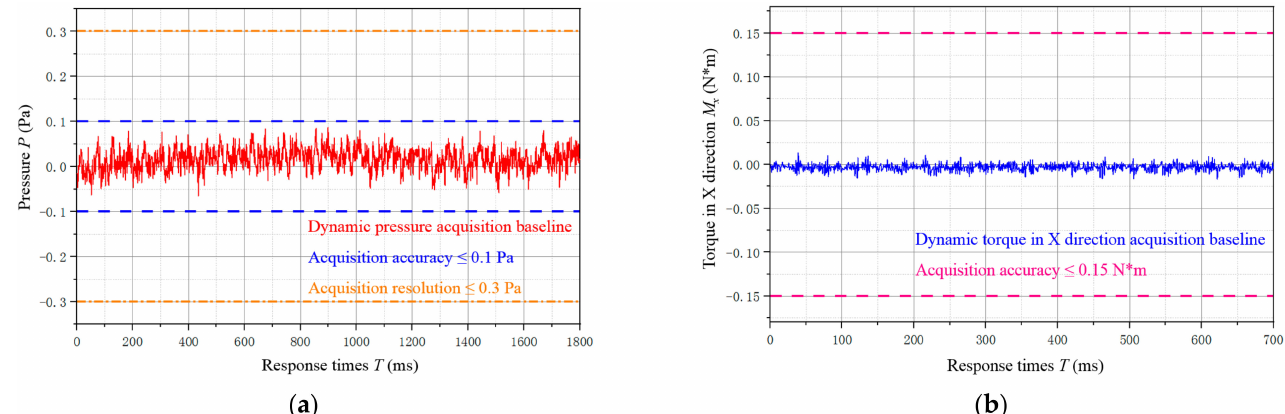
Figure 6. The actual error results of dynamic pressure and force measurement experiments. ( a ) The dynamic pressure measurement baseline results; ( b ) the dynamic torque measurement baseline